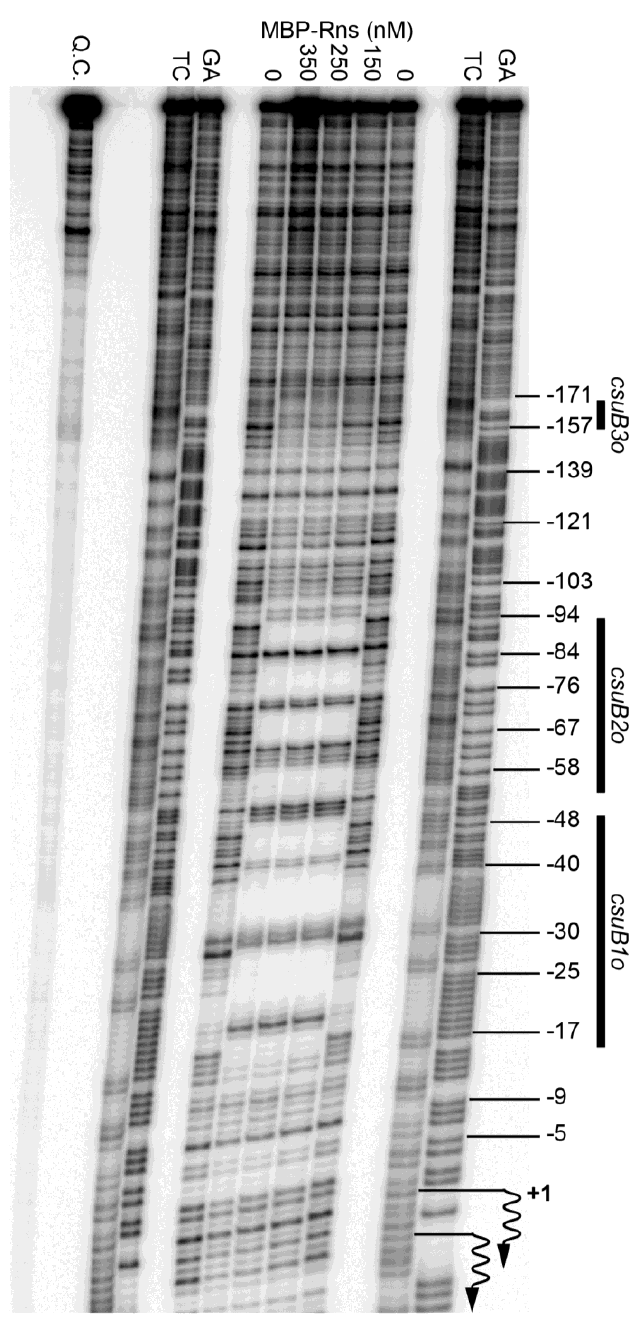
Figure 2. Identification of Rns binding sites. DNase I footprints of MBP-Rns bound the noncoding strand of the CS14 promoter labeled with 32 P at its 5’ end. Numbering is relative to the Rns-dependent transcription start site, denoted by wavy arrows. Lanes labeled TC and GA contain Maxam-Gilbert sequencing ladders. Q.C. denotes a template quality control that was not digested with DNase I.